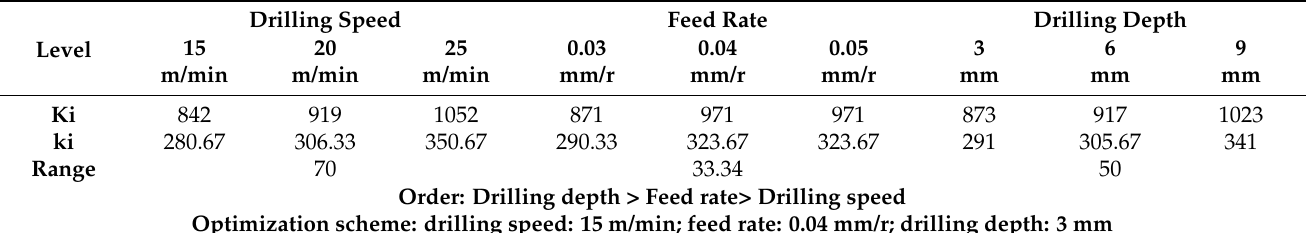
Table 10. Range analysis of drilling